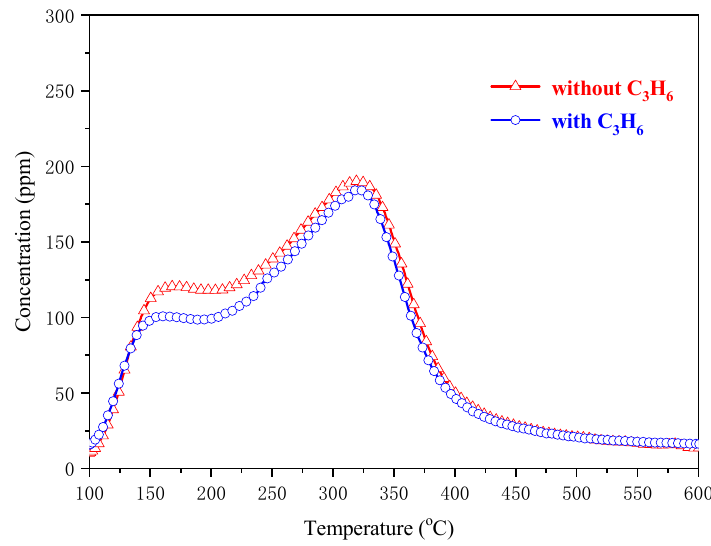
Figure 5. NH 3 -TPD profiles over H-SAPO-34 support with or without C 3 H 6 .